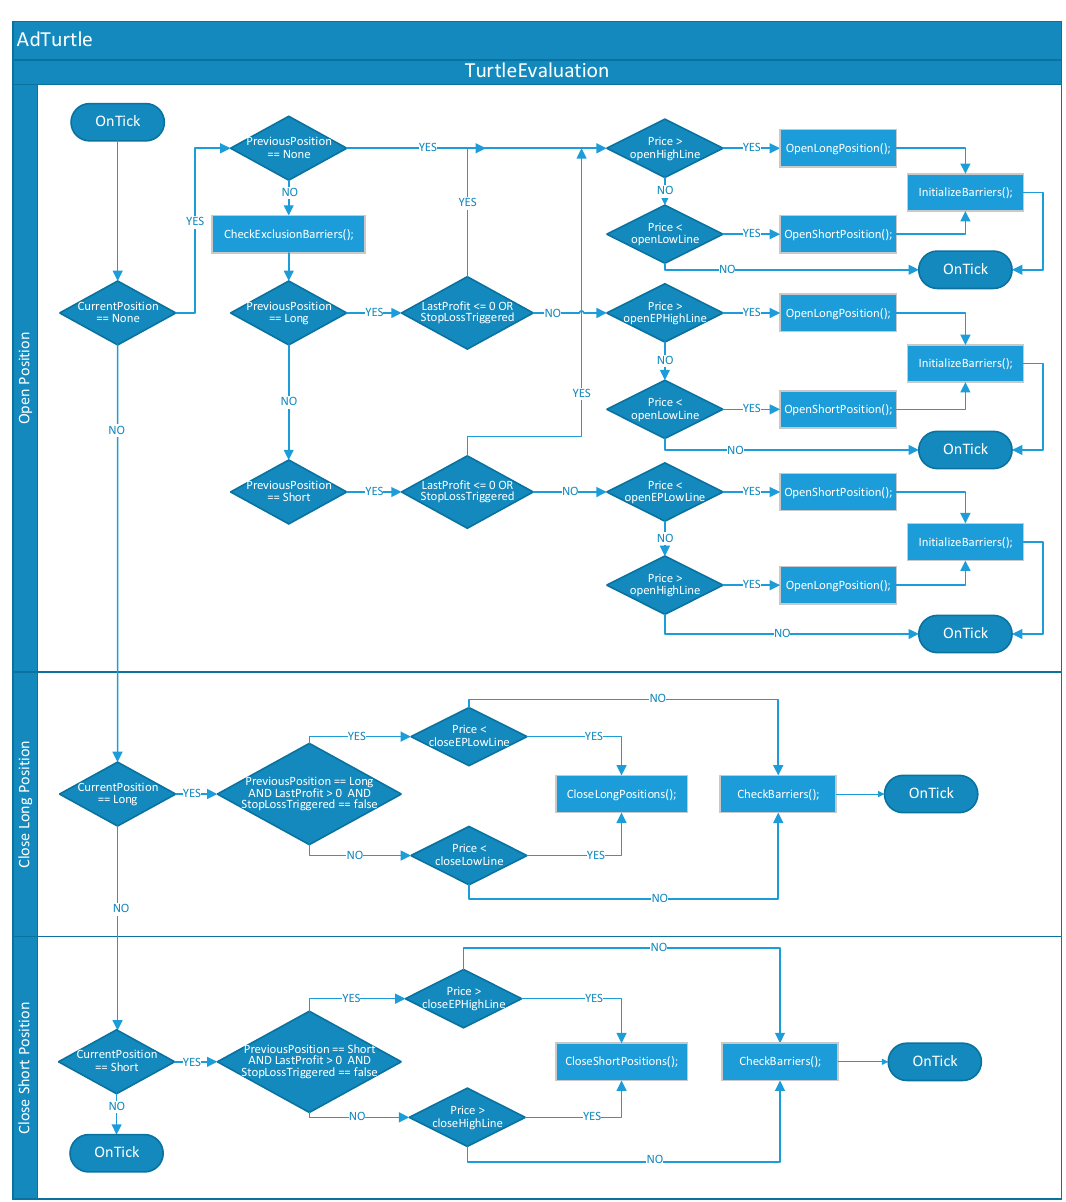
Figure 3. The Turtle basic strategy, showing when a position is opened or closed based on the open high or low lines as described in the sections above.